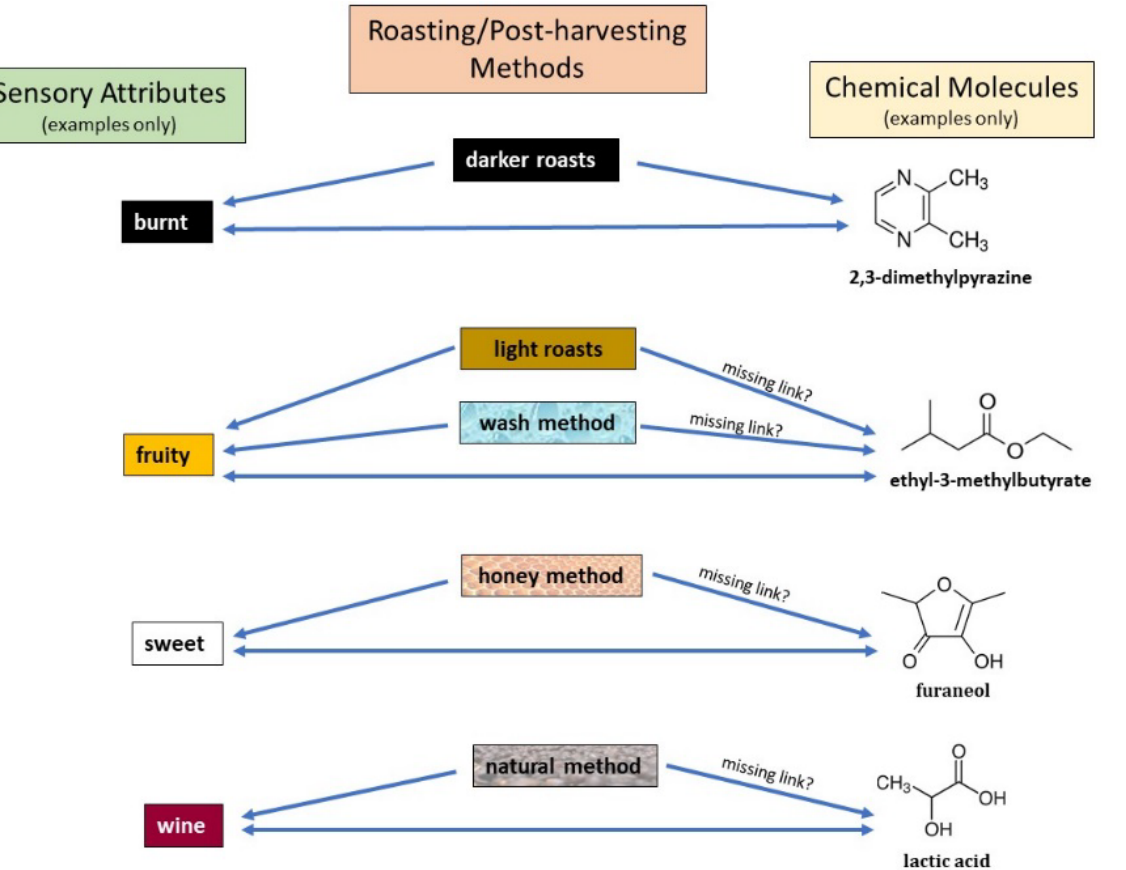
Figure 7. Associations between sensory attributes, molecules, and different coffee roasting/post- harvesting methods [10,141].